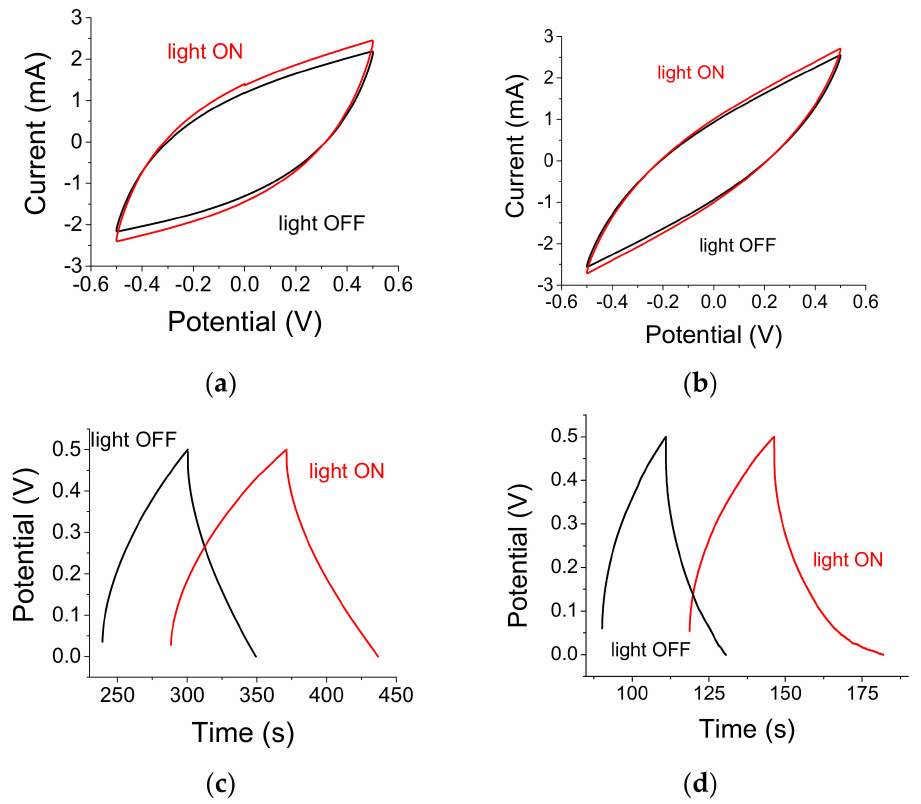
Figure 3. ( a ) CV (at a rate of 0.1 V/s) when a sample is illuminated from the front (where the SiC particles are) and ( b ) when another sample is illuminated from the back (without SiC particles) ( c ) CD for sample ( a ) (excited with a current of 0.2 mA) under light and dark conditions. ( d ) SiC embedded A-C electrode with ITO (front, facing the light) and Al (at the sample back) both used as current